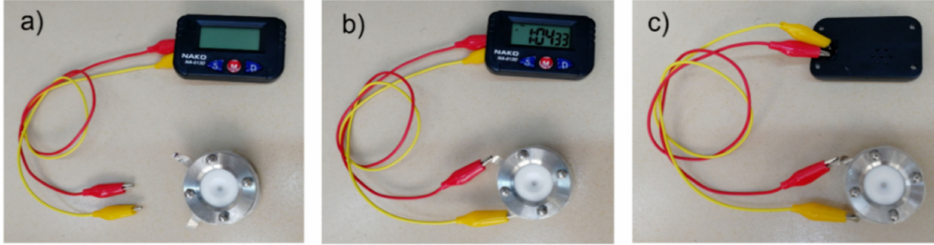
Figure 10. Application of the asymmetrical two-electrode assembled cell (NiO/C (60 wt% NiO) as a positive electrode and CB Timcal Super C65 as a negative electrode) in a 6 M KOH aqueous solution: ( a ) photograph of an asymmetrical two-electrode assembled cell charged at 0.5 mA and a battery-free quartz clock; ( b ) photograph of a quartz clock (front side) in the process of charging; ( c ) photograph of a quartz clock (back side) in the process of